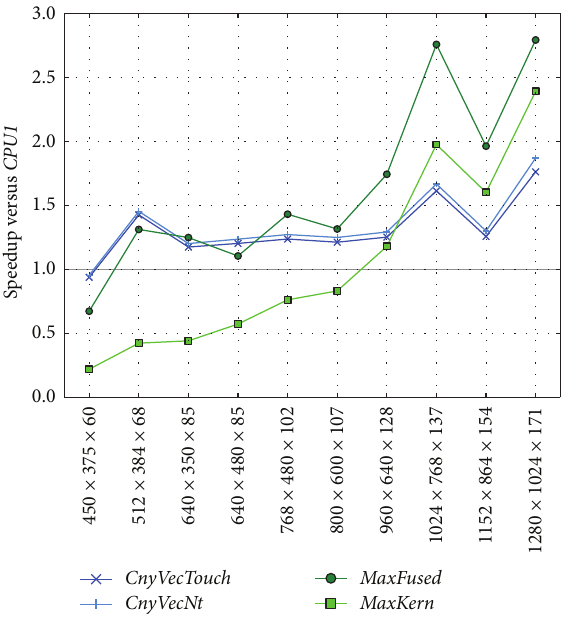
Figure 13: High-disparity image series. Speedups of accelerated configurations compared to faster CPU1 . CnyVec versions are at disadvantage because their host parts run on slower